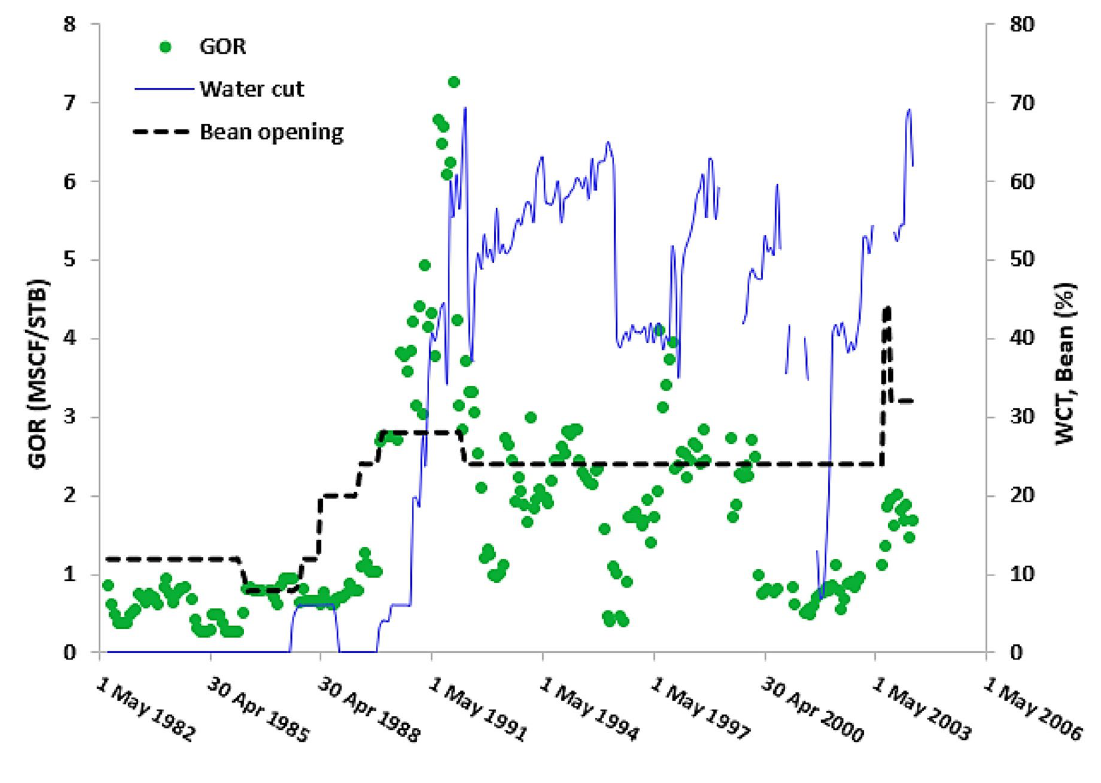
Fig. 16 Production ratios history of well V2‑B